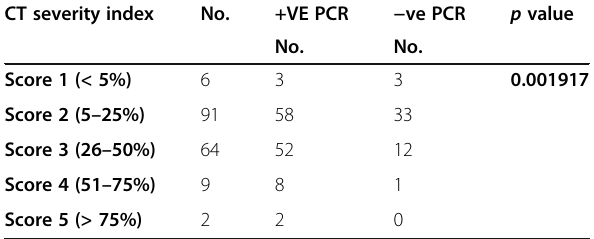
Table 5 Correlation between CT severity index and PCR